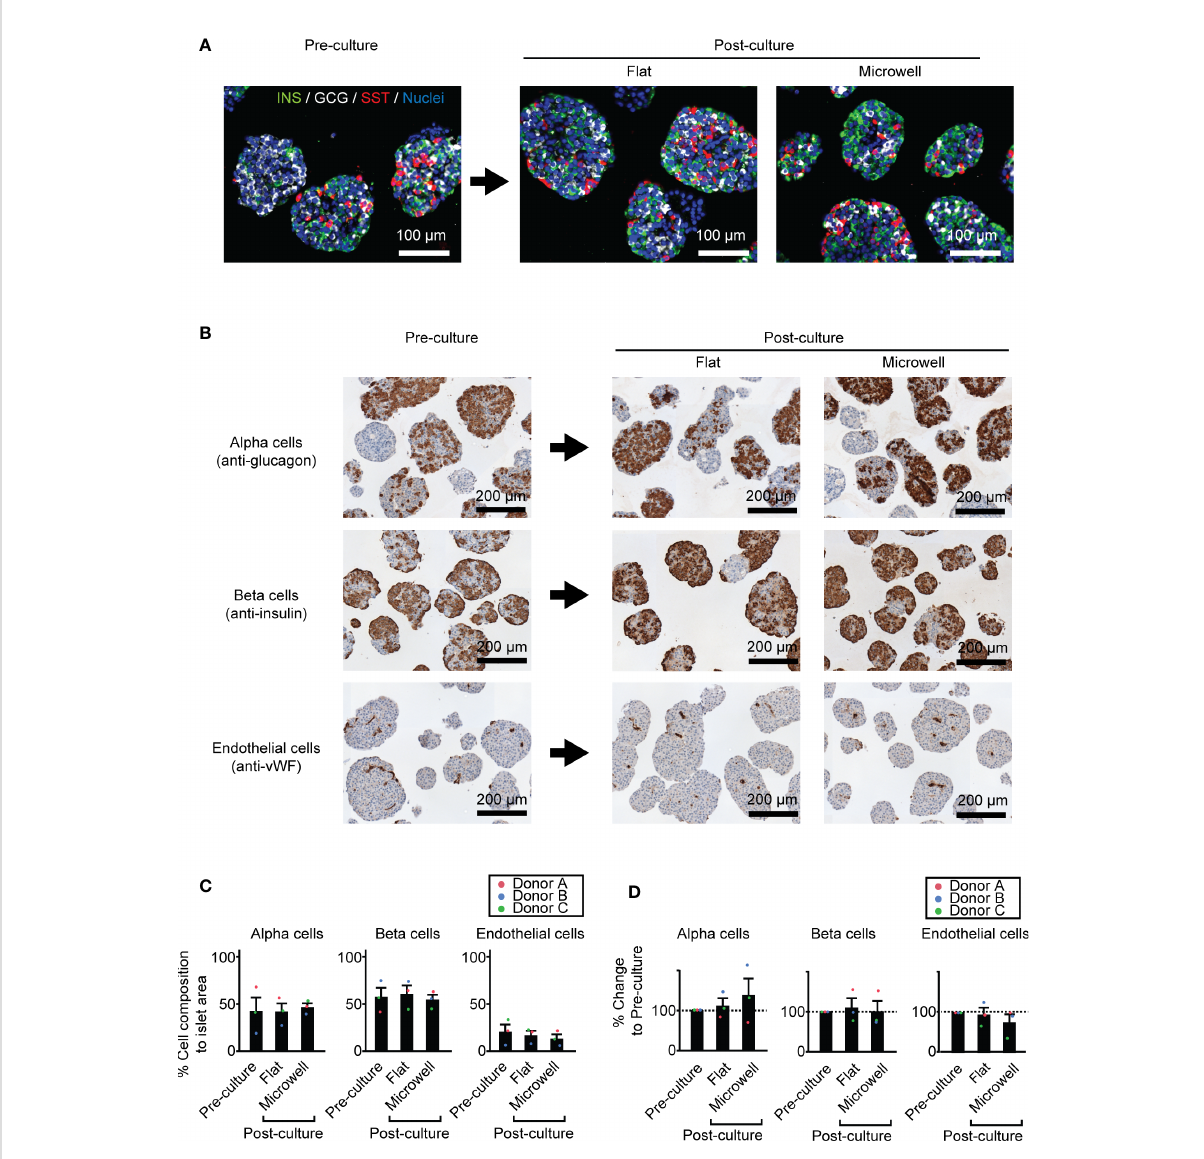
FIGURE 5 Cell composition of key cell types in two week-cultured human islets. (A) Representative immuno fl uorescence images of pre- and post- cultured ( fl at dish and microwell dish) islets with major endocrine components (insulin, glucagon and somatostatin. Scale bar: 100 µm. (B) Representative immunohistochemistry images of pre- and post-cultured islets for area quanti fi cation analyses. Anti-glucagon for alpha cells (upper row), anti-insulin for beta cells (middle row) and anti-vWF for endothelial cells (bottom row). (C) The percent (%) of cell composition to islet area pre- and post-culture time points. n = 3 donors. Data of each donor is plotted in different color dots (red, blue and green for Donors A, B and C, respectively). (D) Analyses of % changes normalized to pre-culture